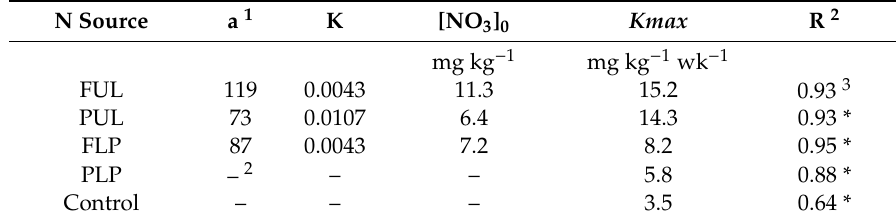
incubation of Norfolk soil amended with four broiler litter materials.